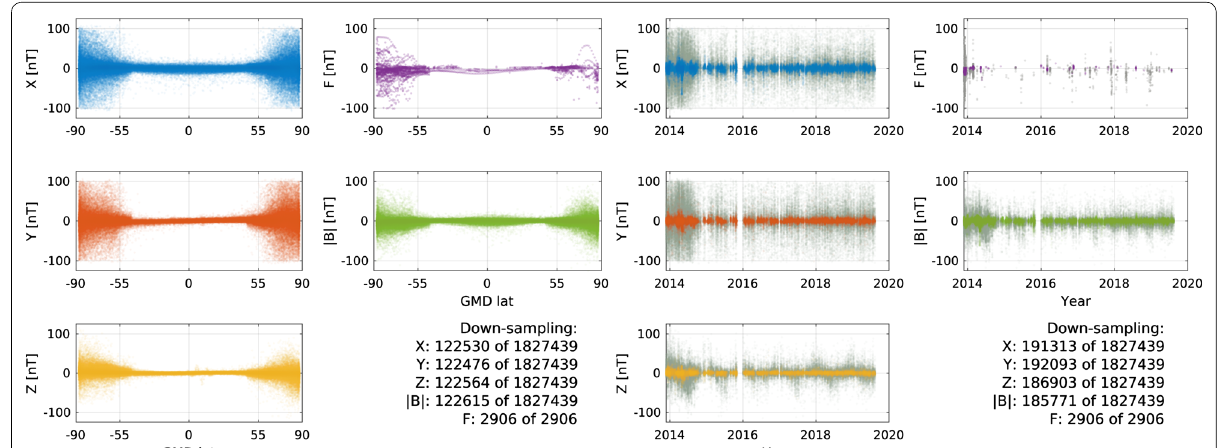
Fig. 3 Unweighted posterior residual fit of the parent model to Swarm data. Left: Residuals by GMD latitude. Right: Residuals by time, with high-latitude ( ≥ | 55| ◦ GMD latitude) data marked in grey, and mid- to low-latitude data in colour. Note the data are downsampled for simpler visualisation, but retain their 2 σ outliers. Data numbers count vector triples as